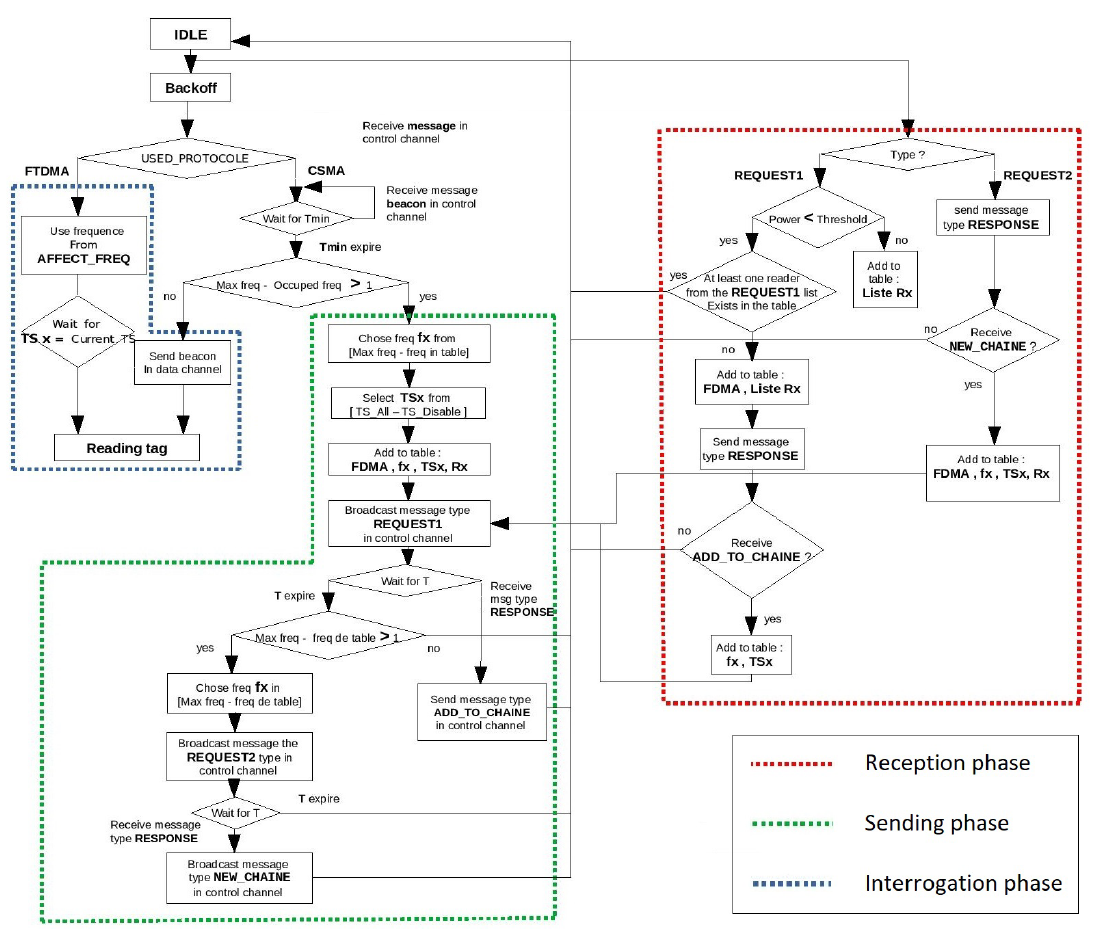
Figure 4. Proposed algorithm structure .